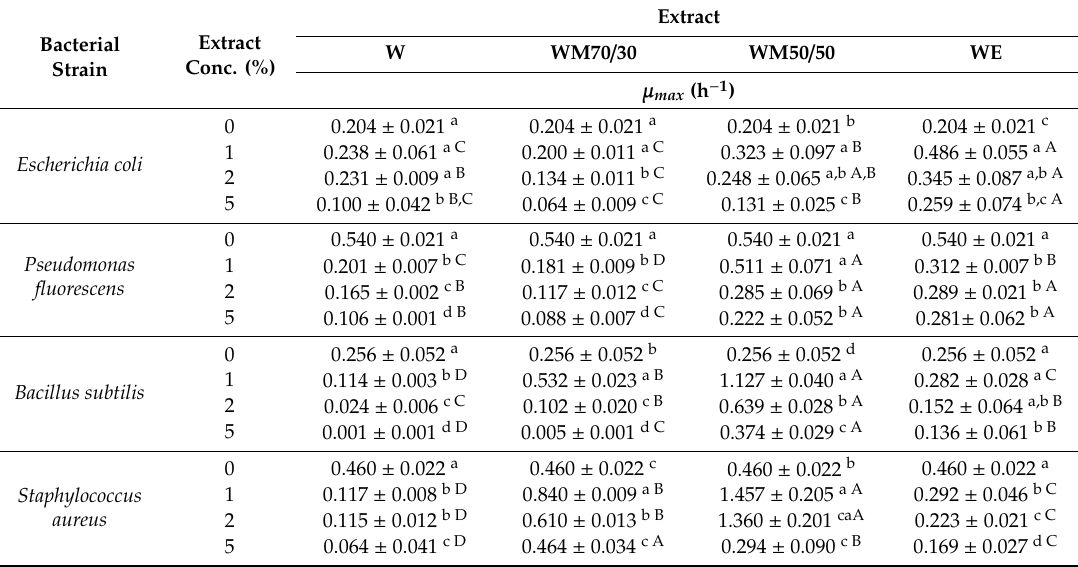
Table 4. E ff ect of chicory root extracts on maximum specific growth rate ( µ max ) of bacteria. Extract Bacterial W WM70 / 30 WM50 / 50 WE Conc. (%) Strain